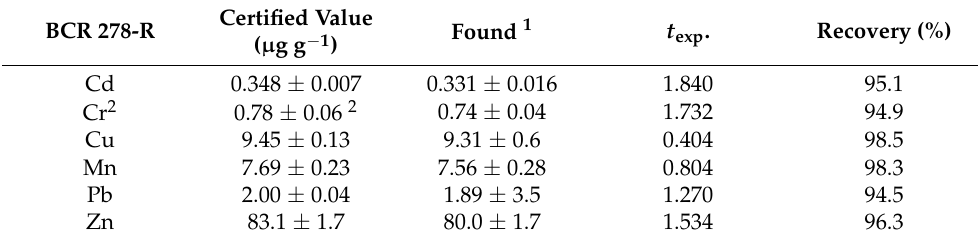
Table 4. Analytical results of in CRM BCR 278-R by the developed ICP-AES method